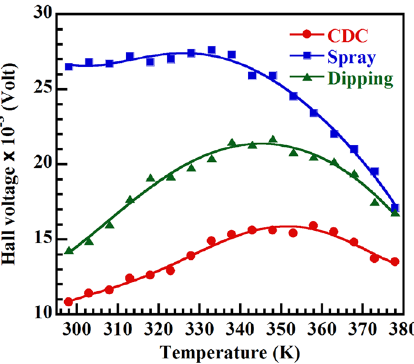
Figure 1. Hall voltage of CH 3 NH 3 PbI 3−x Cl x . Variation of Hall voltage at constant magnetic field of 9.815 KG with temperature for CH 3 NH 3 PbI 3−x Cl x thin films using Hall measurement